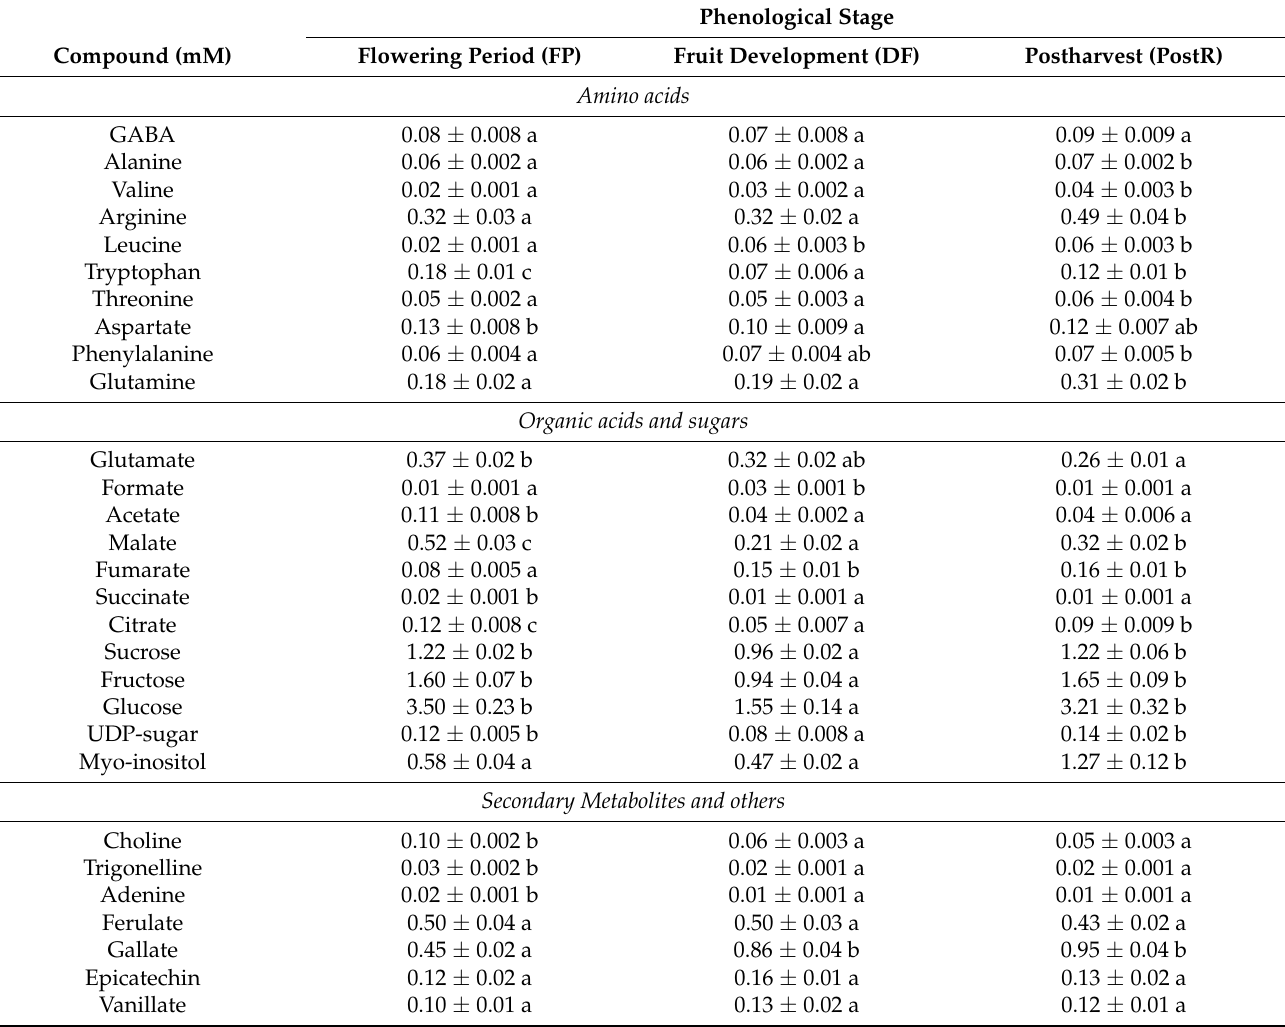
Table 4. Metabolomic analysis for three phenological stages (flowering period (FP), fruit development (DF), and postharvest (PostR)) The results show are the mean values in mM ±